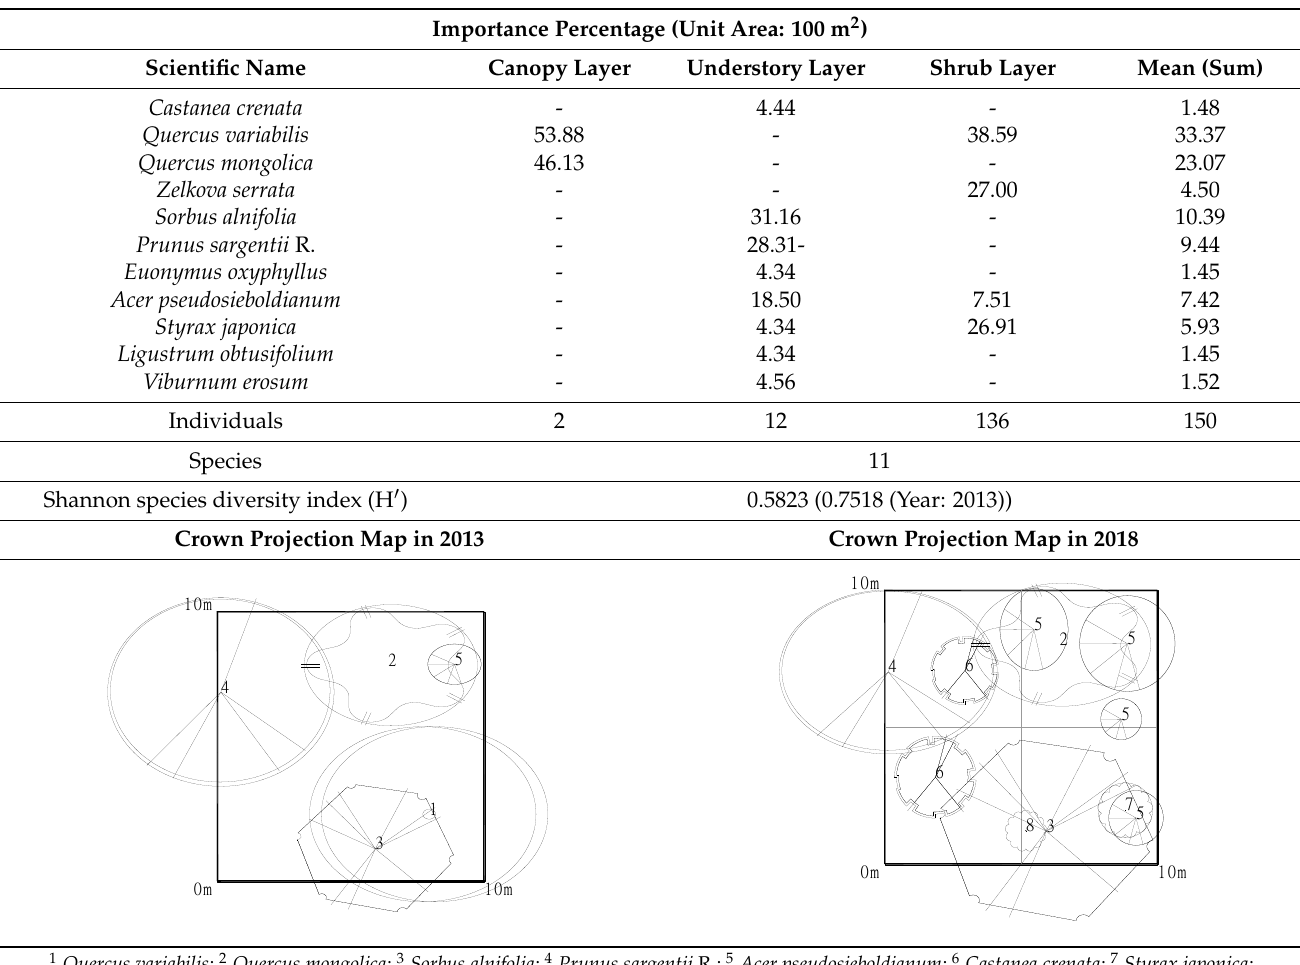
Table 7. Plant community structure of the Quercus variabilis—Quercus mongolica community (survey plot no. 19) in the forest of the Changdeokgung Rear Garden.